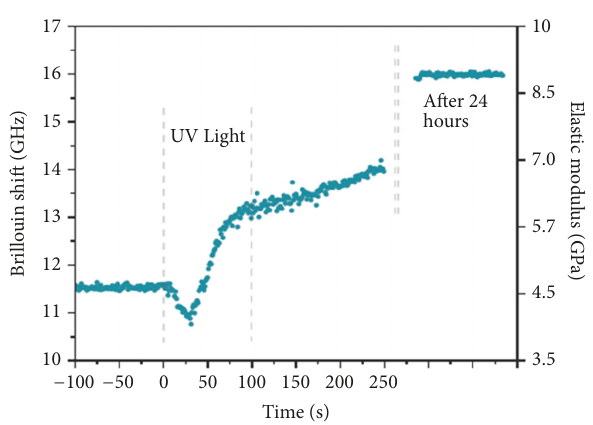
Figure 5: Real-time monitoring Brillouin shift frequency during UV-induced crosslinking of polymer [adapted from [7]].